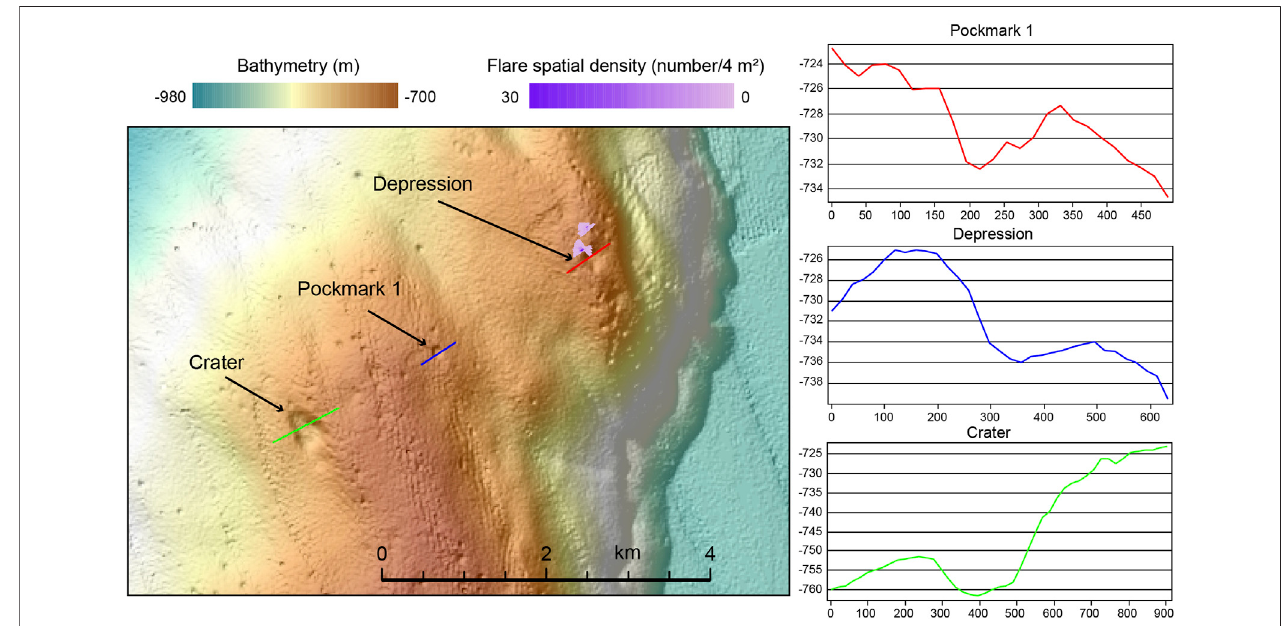
FIGURE 12 | Zoom in of the area of pockmarks and gas fl ares outlined in black in Figure 11A . On the right, bathymetric pro fi les of an average pockmark and the crater, where no gas fl ares have been detected, and of the depression where gas fl ares are more concentrated on top of RMV.